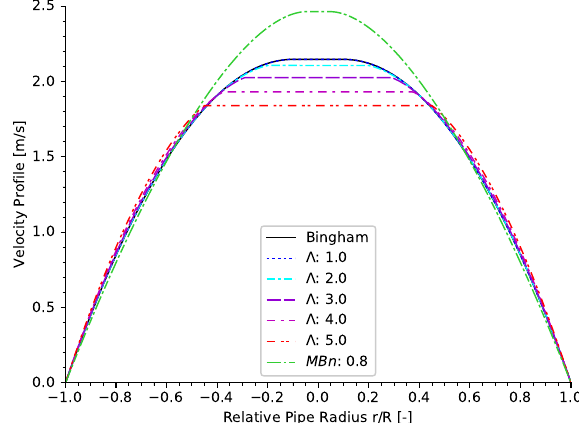
Figure 6: For a higher discharge rate of 10 L / s ( ̂︀ Q = 2.18 with R = 52.65 mm ), the velocity profile shows to have a smaller plug, yet bigger plug for increasing thixotropy factors Λ . The transition from plug to shearing happens more smooth for a higher flow rate, because the flow regime approximates a Bingham flow